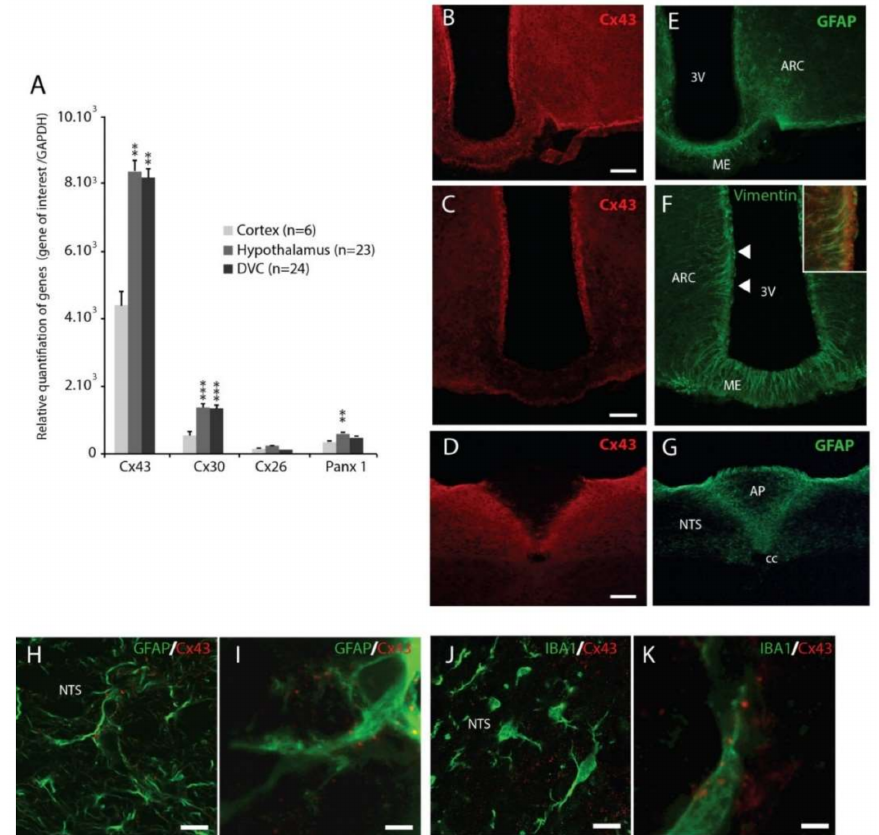
Figure 1. ( A ): Glial connexins and pannexin1 mRNAs quantification measured by reverse transcriptase quantitative polymerase chain reaction (RT-qPCR) in the cortex, hypothalamus and DVC of control mice ( n = 6, 23 and 24 respectively). ** p < 0.01 and *** p < 0.001 compared to cortex. ( B – G ): Confocal images of Connexin-43 (Cx43) (red) and Glial Fibrillary Acidic Protein (GFAP) ( E – G ) or vimentin ( F ) double labeling immunohistochemistry performed within the hypothalamus and Dorsal Vagal Complex (DVC). Scale bar: 200 µ m. Inset in F shows Cx43 and vimentin co-localization in α -tanycytes. ( H , I ): Confocal images Cx43 (red) and GFAP (green) double immunofluorescence within the DVC. Cx43 is strongly associated with astrocytes GFAP + (green) processes. ( J , K ): Confocal images of Cx43 (red) and Ionized Ca 2 + Binding Adapter Molecule 1 (IBA1) (green) double immunofluorescence within the DVC. Note that Cx43 labelling is sometimes found associated with thin processes of IBA + microglia. Scale bars: 20 µ m for ( H , J ) and 2 µ m for ( I ) and ( K ). AP: area postrema, NTS: nucleus tractus solitarius, cc: central canal; ARC: arcuate nucleus, 3V: third ventricle, ME: median